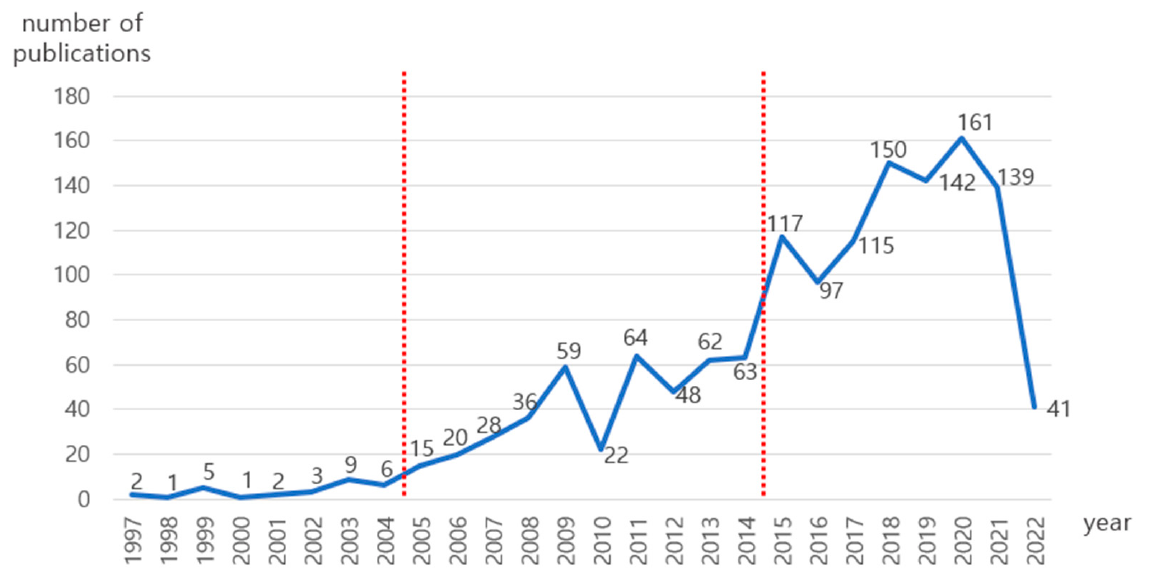
Figure 1. Number of publications by year